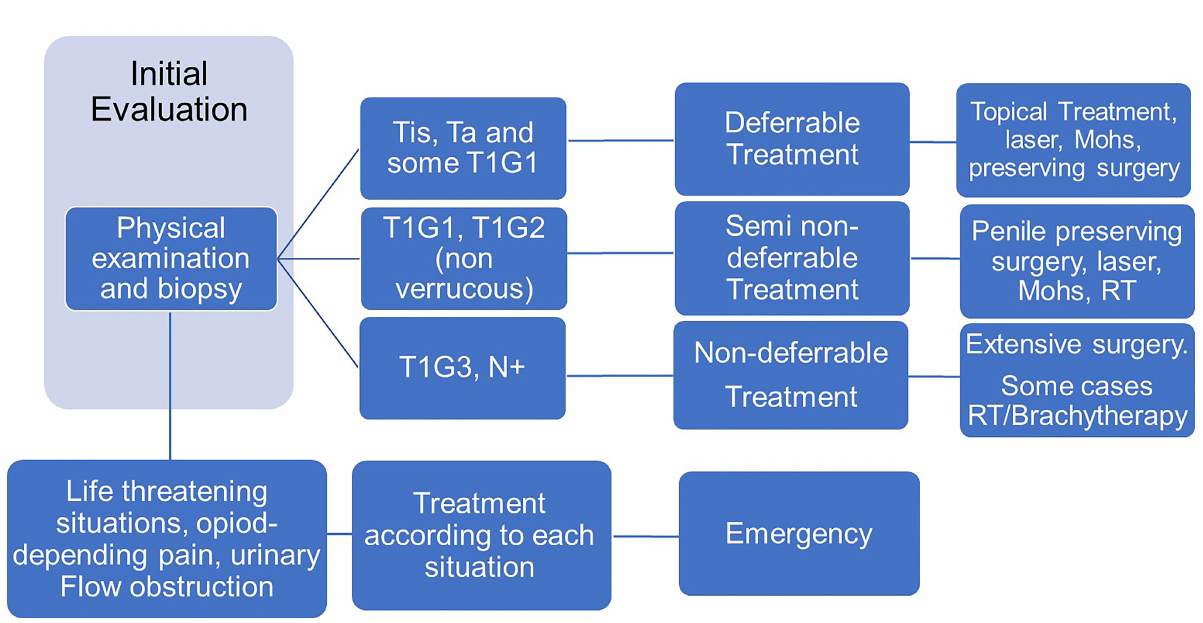
Figure 1 - Decision-making recommendations for Penile Cancer during COVID-19